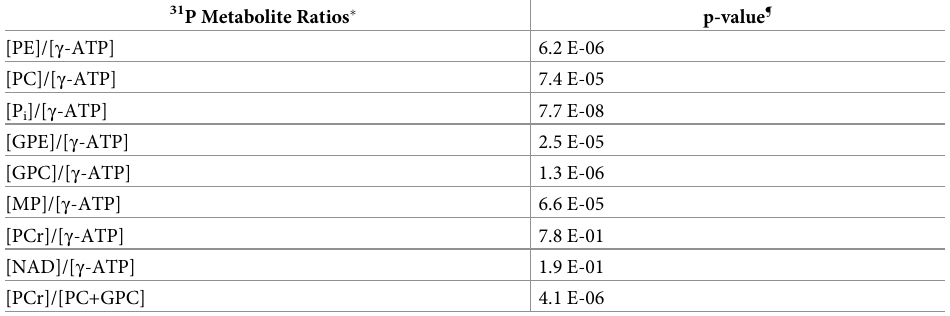
� Calculated by averaging fitting results obtained from the four different spectral models of MP. ¶ Student t -tests (two-tailed, unpaired) without Bonferroni corrections. PE: phosphoethanolamine; PC: phosphocholine; Pi: inorganic phosphate (intracellular inorganic phosphate plus extracellular inorganic phosphate); GPE: glycerophosphoethanolamine; GPC: glycerophosphocholine; MP: membrane phospholipids; PCr: phosphocreatine; γ -ATP: γ -adenosine triphosphate; NAD: nicotinamide adenine